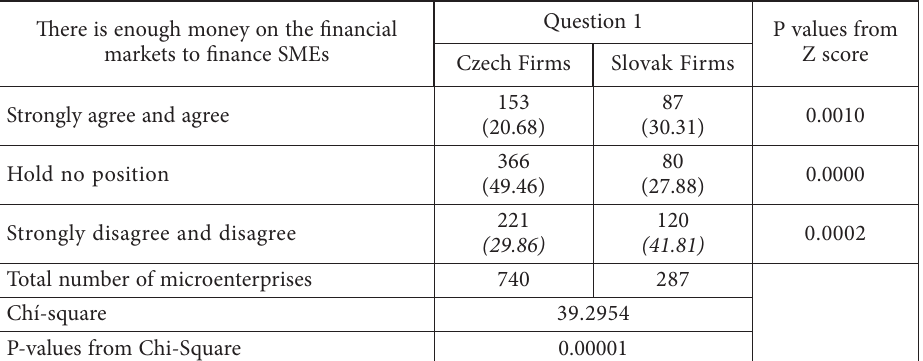
Table 2. Differences in the perception of microenterprises’ financing from financial markets (source: own processing) There is enough money on the financial markets to finance SMEs Strongly agree and agree